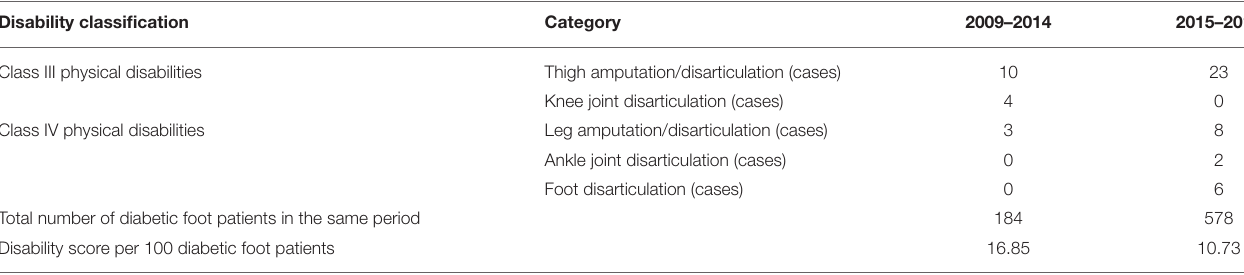
TABLE 6 | Changes of the disability in patients with diabetic foot from 2009 to 2014 and 2015 to